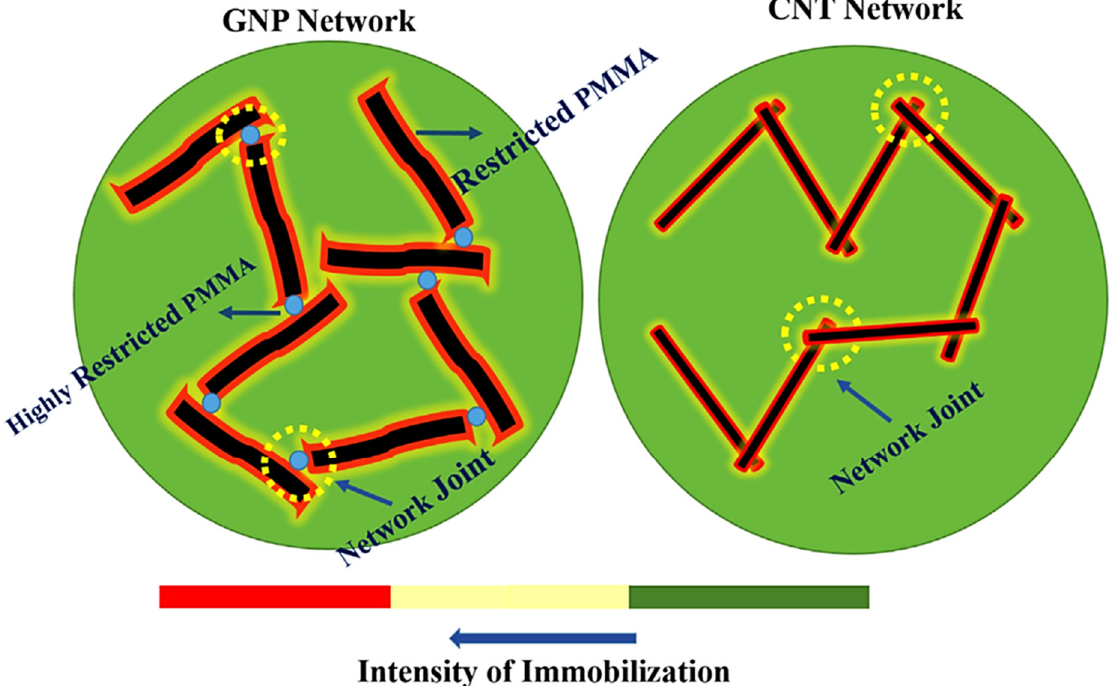
Figure 7. Schematic of polymer-mediated network in GNP and CNT network with direct contacts of CNT [57]. GNP = graphene nanoplatelet; CNT = carbon nanotube. Reproduced with permission from Elsevier.